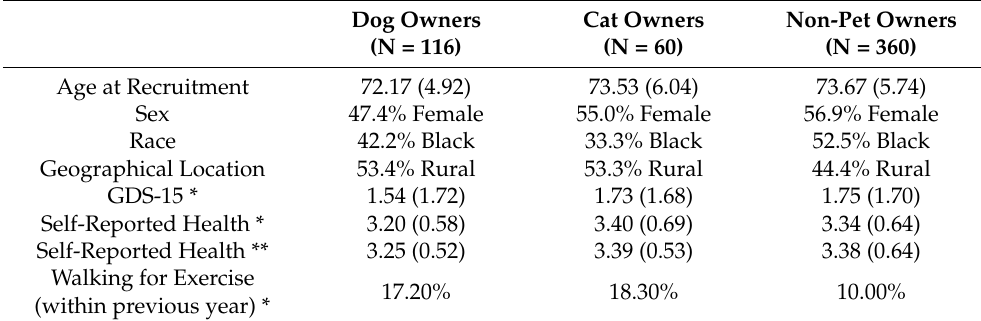
Table 1. Participant Characteristics.